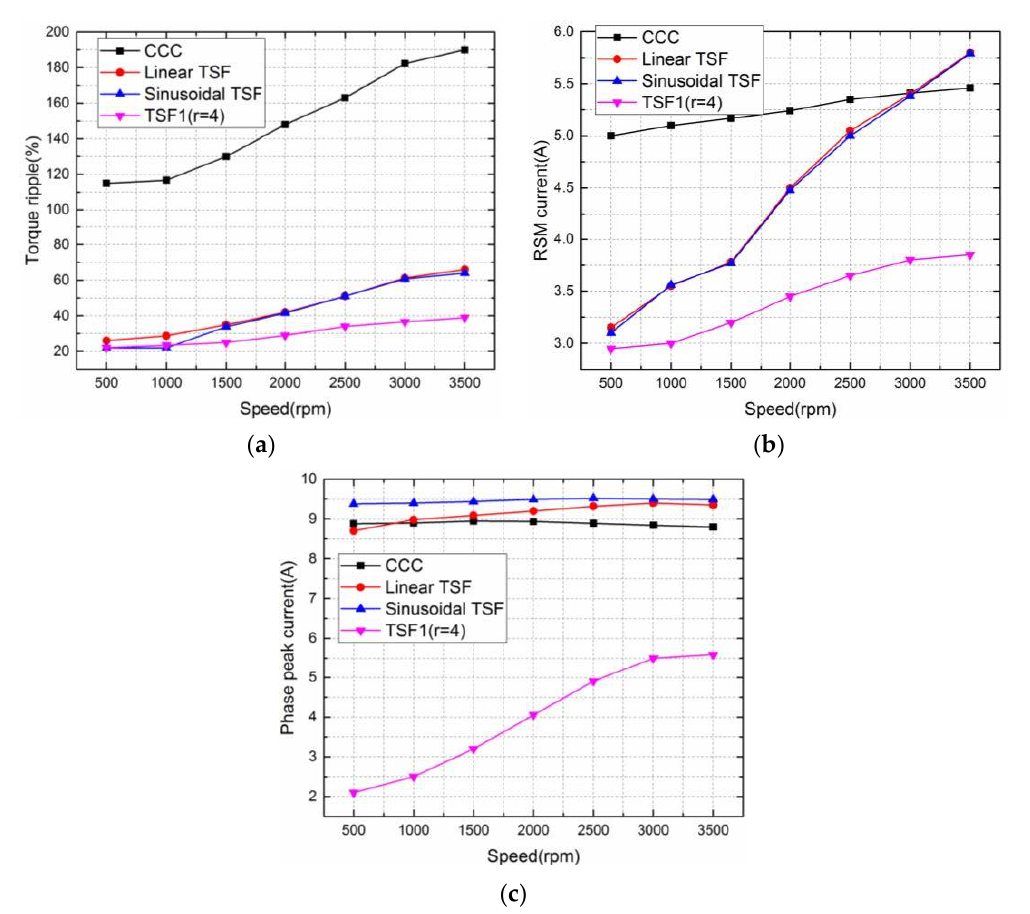
Figure 13. Comparison of CCC and different TSFs: ( a ) torque ripple; ( b ) rms phase current; ( c ) peak current.